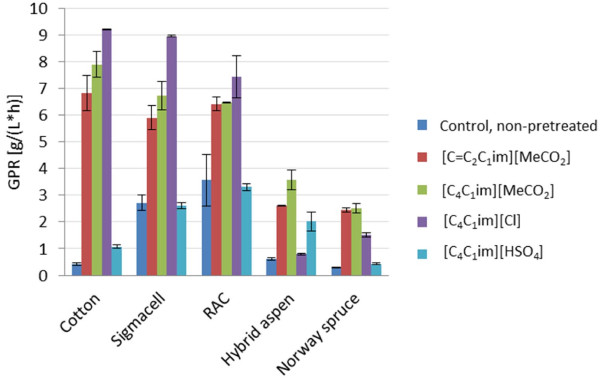
Glucose production rate (GPR) in g glucose l-1 h-1after 2 h of enzymatic hydrolysis (before the reaction rates level off) for the ionic-liquid-pretreated samples and the non-pretreated control.